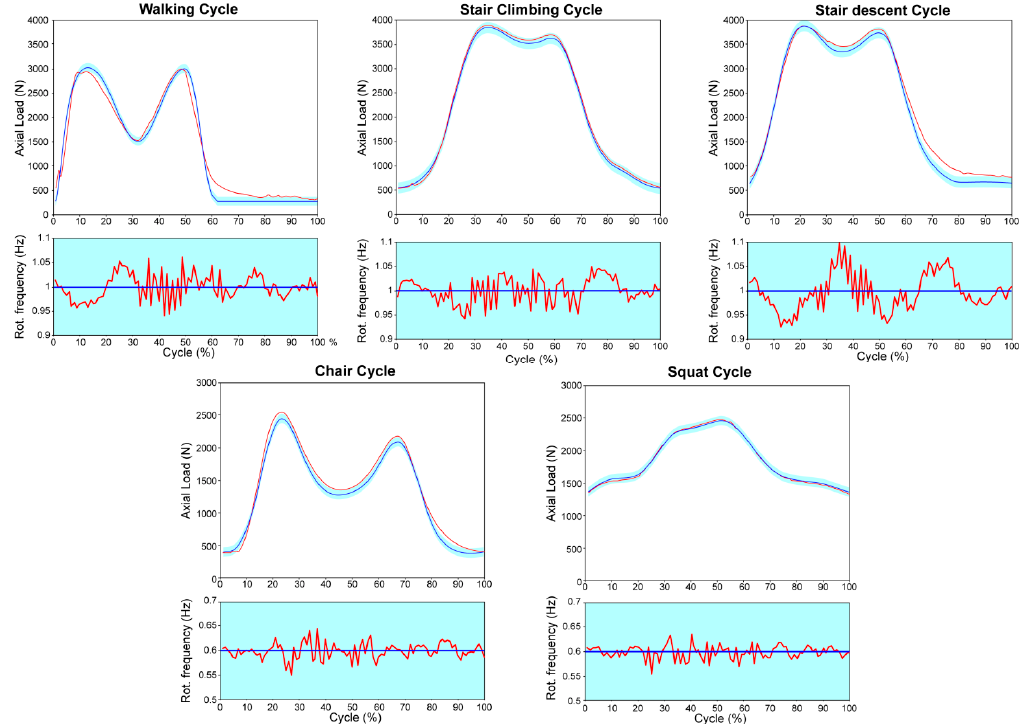
Figure 2. Load waveforms and rotation frequency for each considered motor task and machine response.